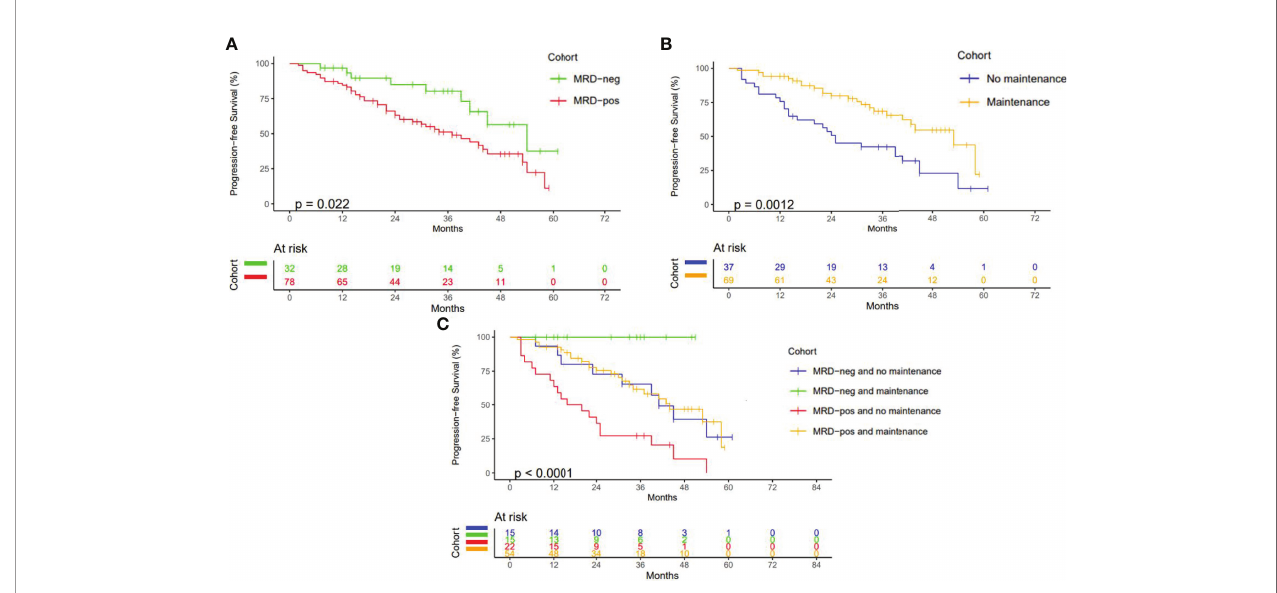
FIGURE 1 | Progression Free Survival (A) PFS according to MRD status. (B) PFS according to maintenance therapy received. (C) PFS according to MRD status and maintenance therapy